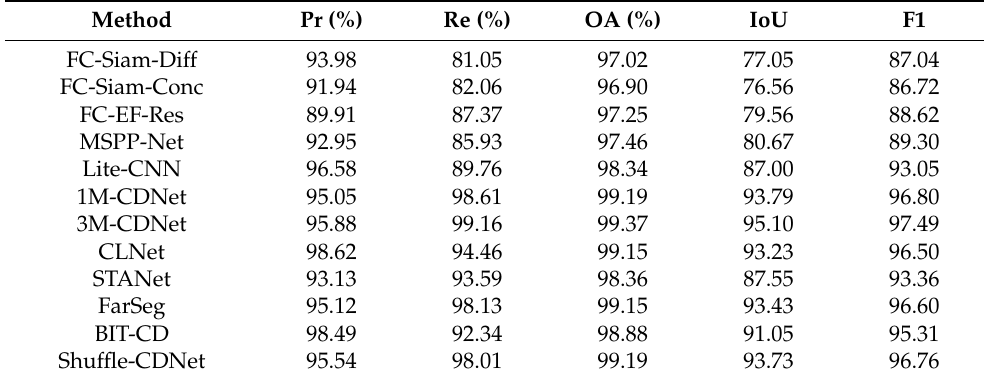
Table 3. Comparison results on the season-varying dataset.